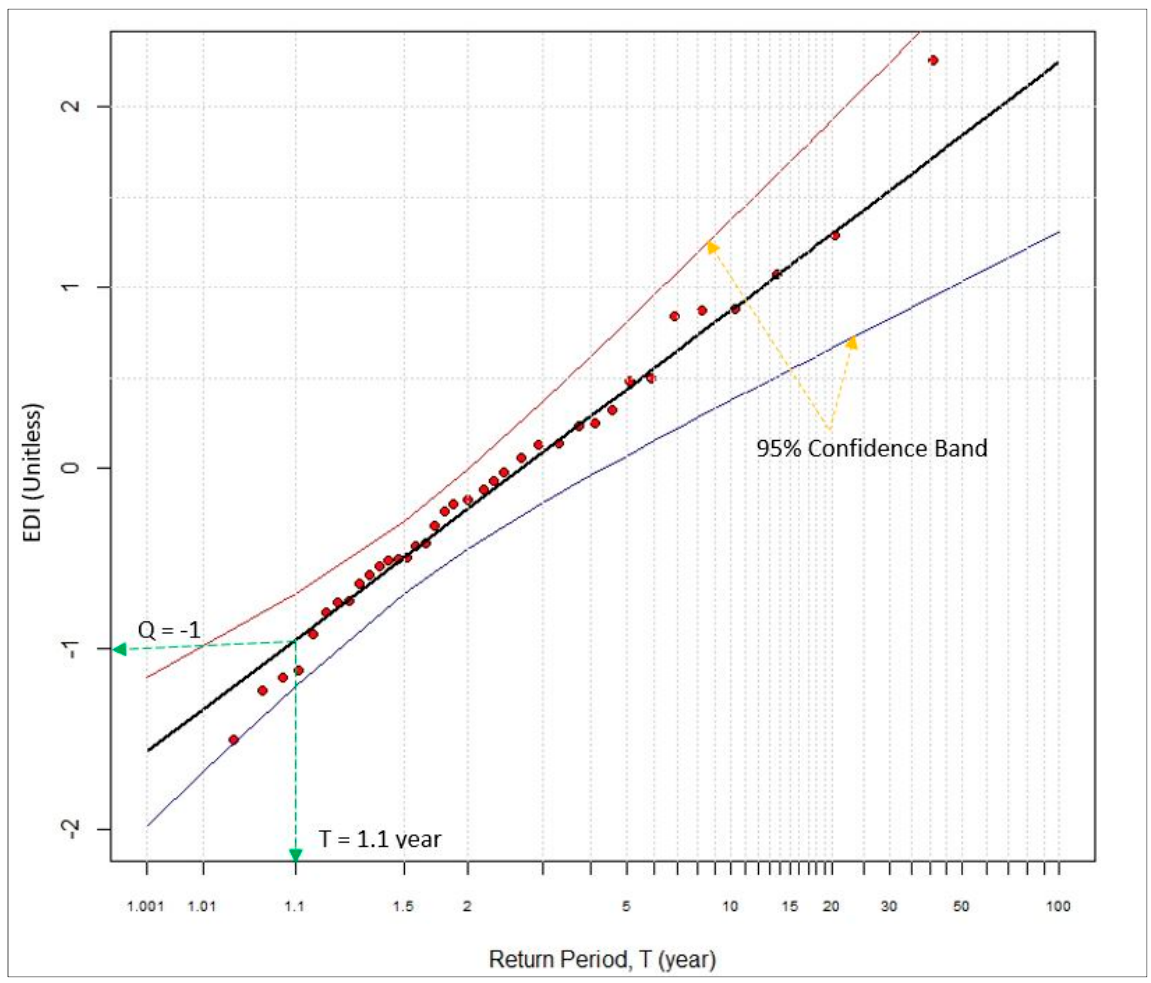
Figure 2. Sample plot of frequency analysis using the Effective Drought Index (EDI) for the period from 1980 to 2019, illustration to guide interpretation.